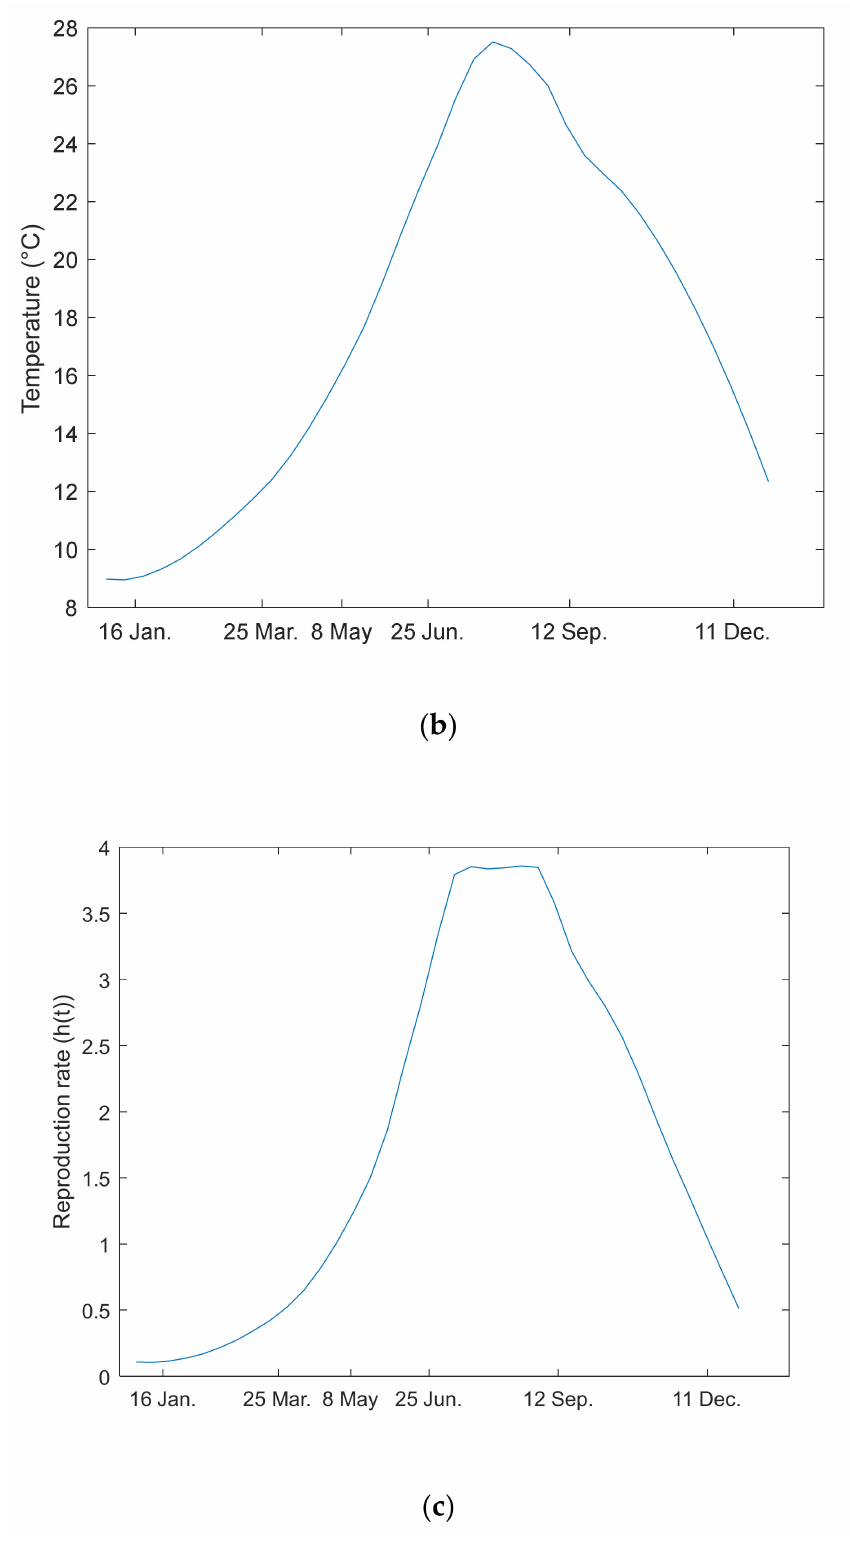
Figure 2. ( a ) Temperature-dependent annual reproduction rate year, h ( T ) , constructed by fitting the curve to the data [bar] [21] which are rescaled to 365 days after adding the number of directly budded and stolonic budded polyps in the experiment of Han and Uye [21]; ( b ) annual temperature in Tokyo Bay, 2011 [13]; ( c ) annual reproduction rate, h ( t ) , constructed by inserting the annual temperature distribution to h ( T )